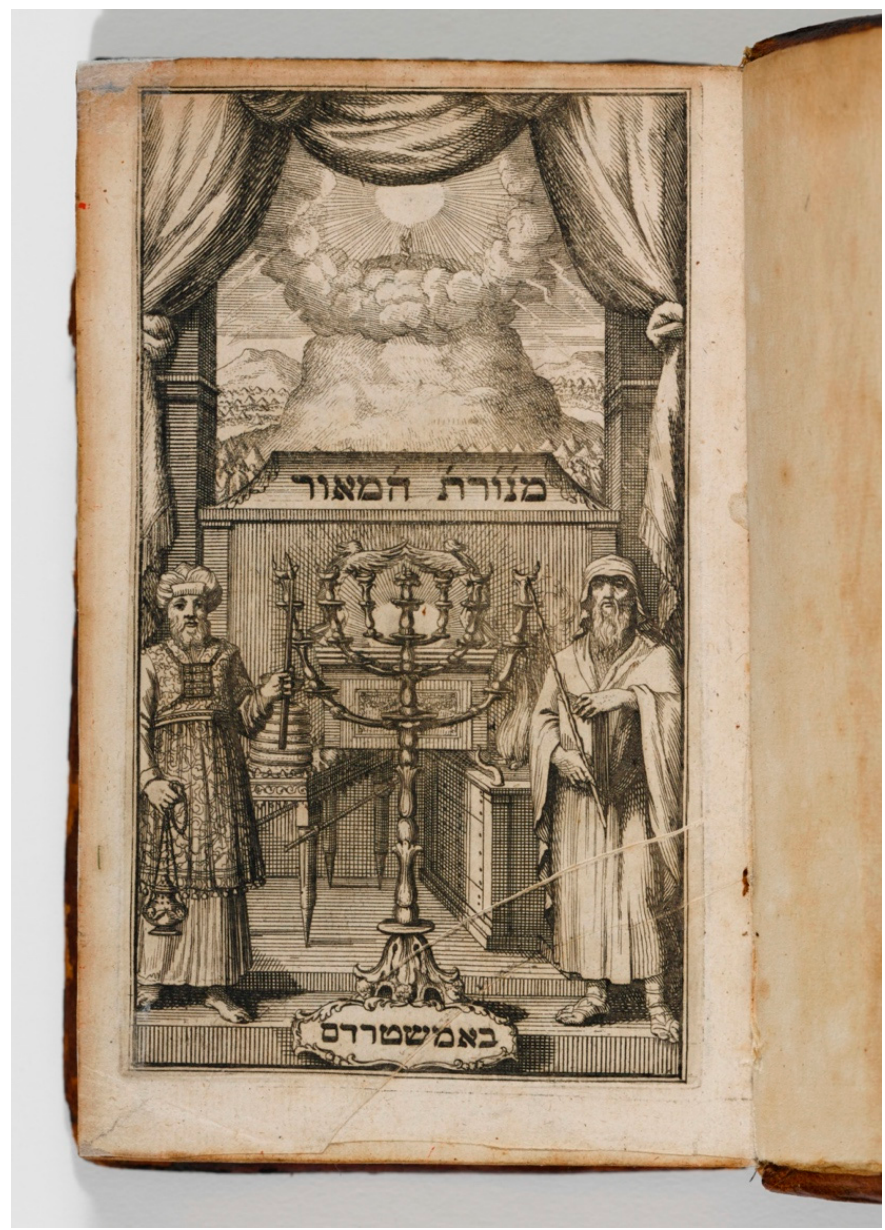
Figure 31. Menorat Ha-Ma’or (Candelabra of Light); Marsh’s Library C.3.4.28.